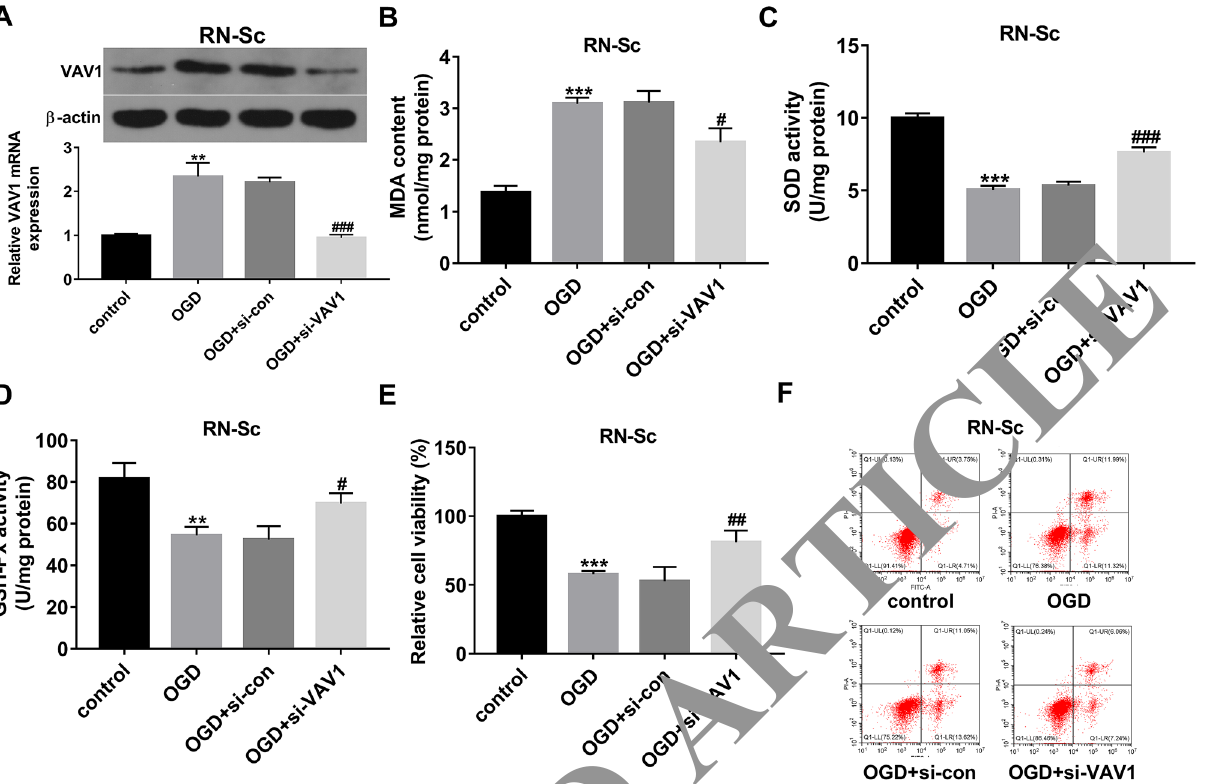
Figure 5. VAV1 knockdown weakened OGD-triggered oxidative stress and cell injury. ( A – F ) RN-Sc cells were transfected with si-con or si-VAV1. At 24 h post transfection, cells were underwent with or without OGD/R treatment, followed by the measurement of VAV1 expression ( A ), MDA content ( B ), SOD activity ( C ), GSH-Px activity ( D ), cell viability ( E ) and cell apoptotic rate ( F ) at 12 h after reoxygenation. ** P < 0.01, *** P < 0.001, # P < 0.05, ## P < 0.01, ### P <